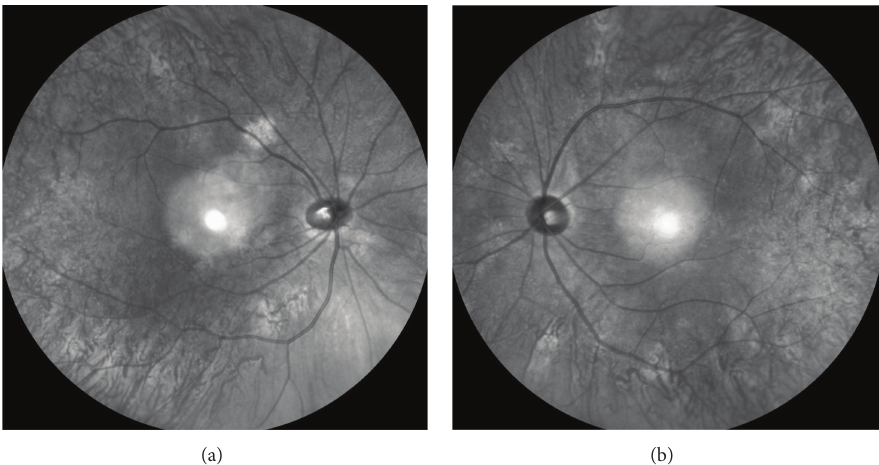
Figure 2: Right (a) and left (b) infrared fundus autofluorescence images. Note multiple bright, patchy lesions in the posterior poles of both eyes. The hyperreflective point at the center of the image is an optical artifact.